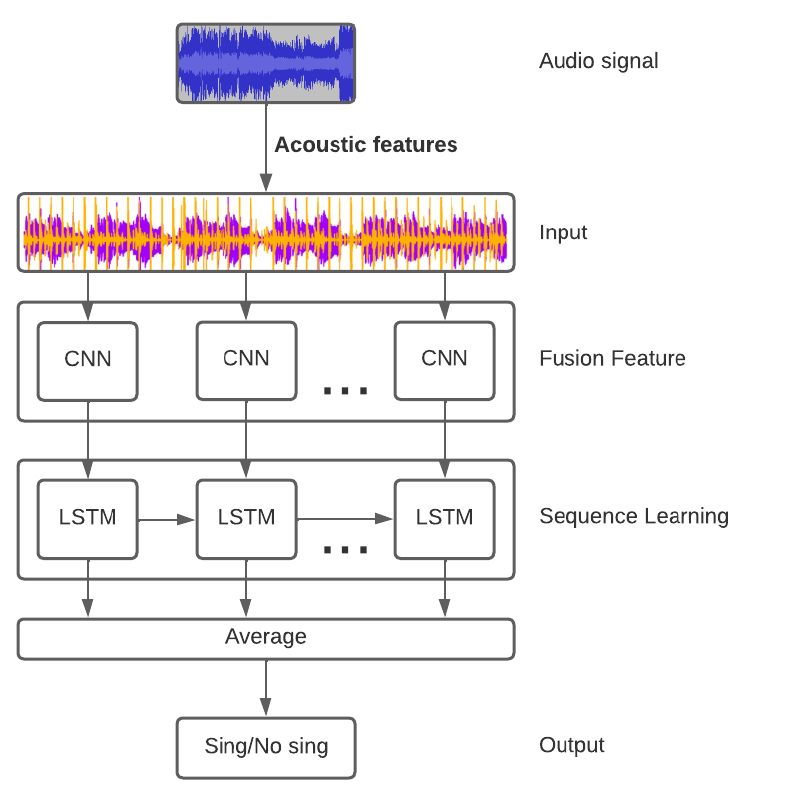
Figure 2. The LRCN has a CNN layer to fuse the audio features into a vector, while the LSTM layer is in order to learn its sequencing to output a sing/nosing label.